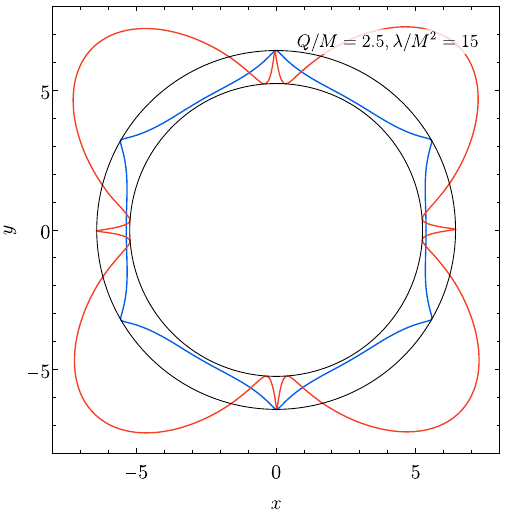
Fig. 35 Projection of bound orbits for the second example